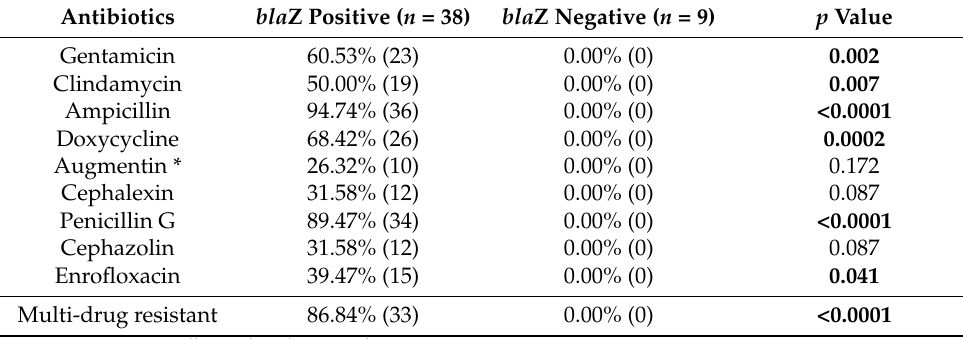
Table 3. Antibiotics resistant profiles comparing between bla Z positive and negative of S. pseudointer- medius from dogs.